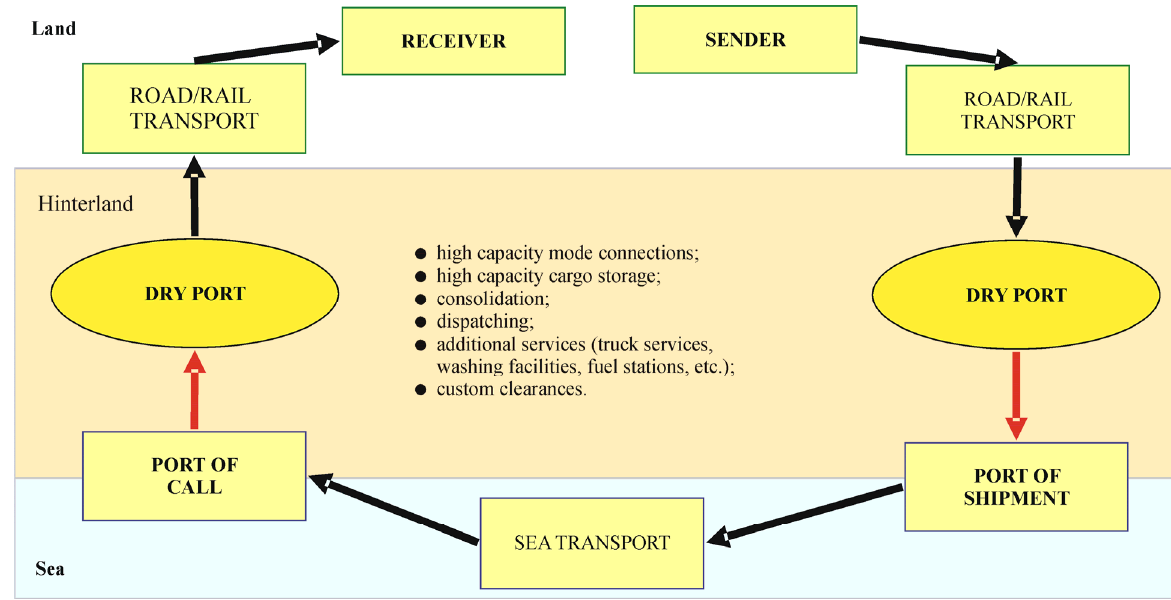
Fig 1. Dry port in the transport chain